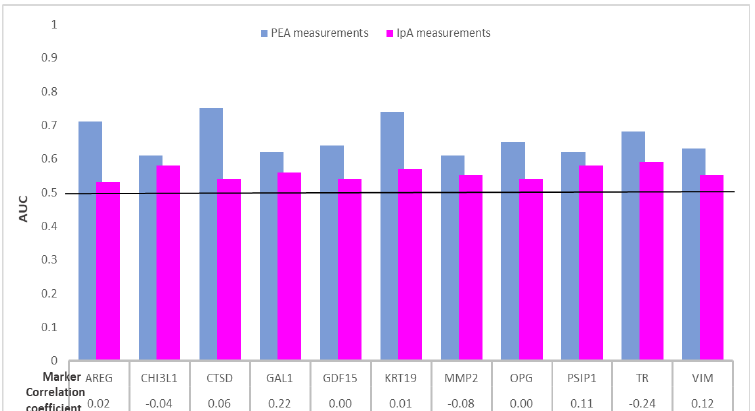
Figure 4. Distribution of AUCs of 11 protein biomarkers overlapping between PEA and IpA measurements for detecting CRC cases from participants in screening colonoscopy. Abbreviations: AREG, amphiregulin; AUC, area under the receiver operating curve; CHI3L1, chitinase-3-like protein 1; CRC, colorectal cancer; CTSD, cathepsin D; GAL1, galectin-1; GDF15, growth differentiation factor 15; IpA, immunome protein array; KRT19, keratin Type I cytoskeletal 19; MMP2, matrix metalloproteinase-2; OPG, osteoprotegerin; PEA, proximity extension assay; PSIP1, PC4 and SFRS1-interacting protein; TR, transferrin receptor protein 1; VIM, vimentin.